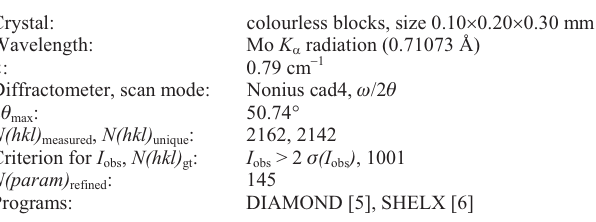
Table 1. Data collection and handling.